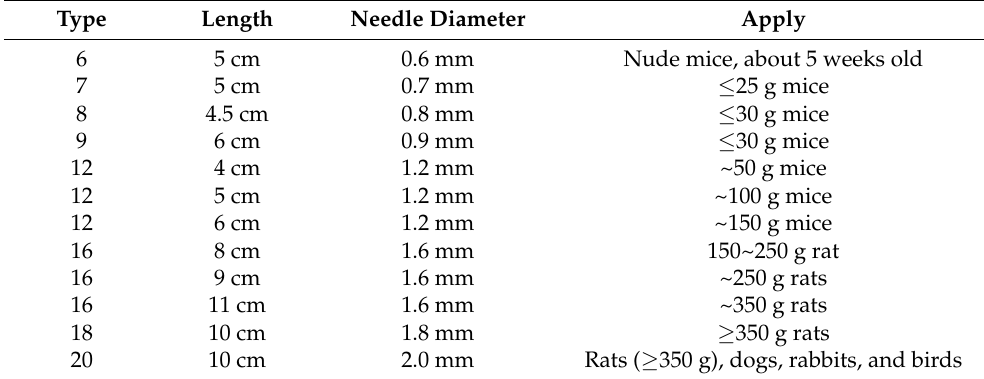
Table 1. Common type and application range of the intragastric needle [40].